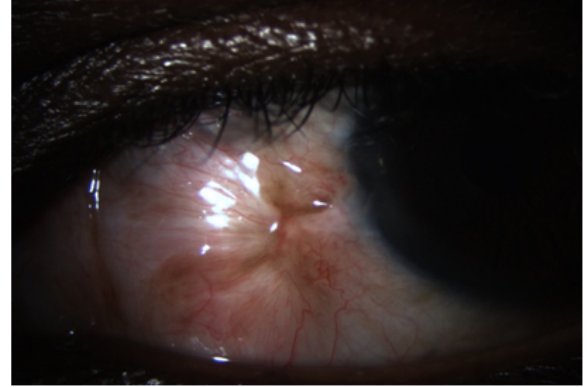
Figure 6: Appearence of the wound bed (LE)